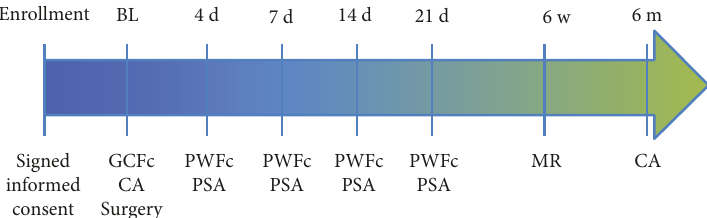
Figure 1: Timeline of the study. GCFc: gingival crevicular fl uid collection; CA: clinical assessments (probing pocket depth, clinical attachment level, full mouth plaque and bleeding, photographs, X-ray); PWFc: periodontal wound fl uid collection; PSA: postsurgical clinical assessments of healing; BL: baseline; d: days; MR: membrane removal.